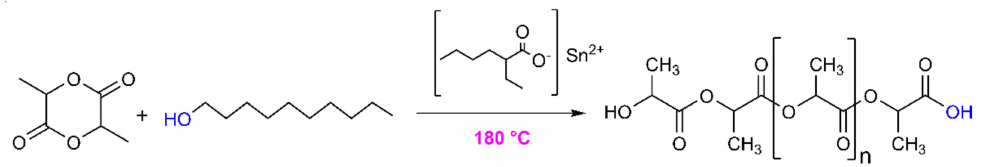
Figure 1. Scheme for the synthesis of PLA by ring-opening